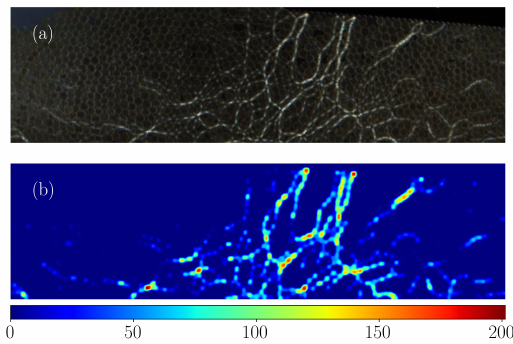
Figure 2: An example of image processing. (a) An original experimental image. (b) A processed image; color scheme shows pixel